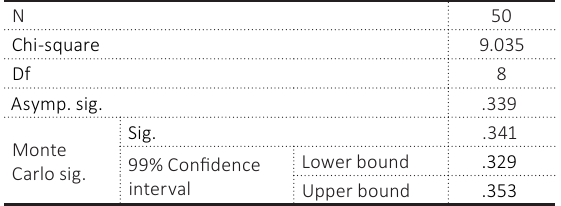
Table 6. Friedman test statistics